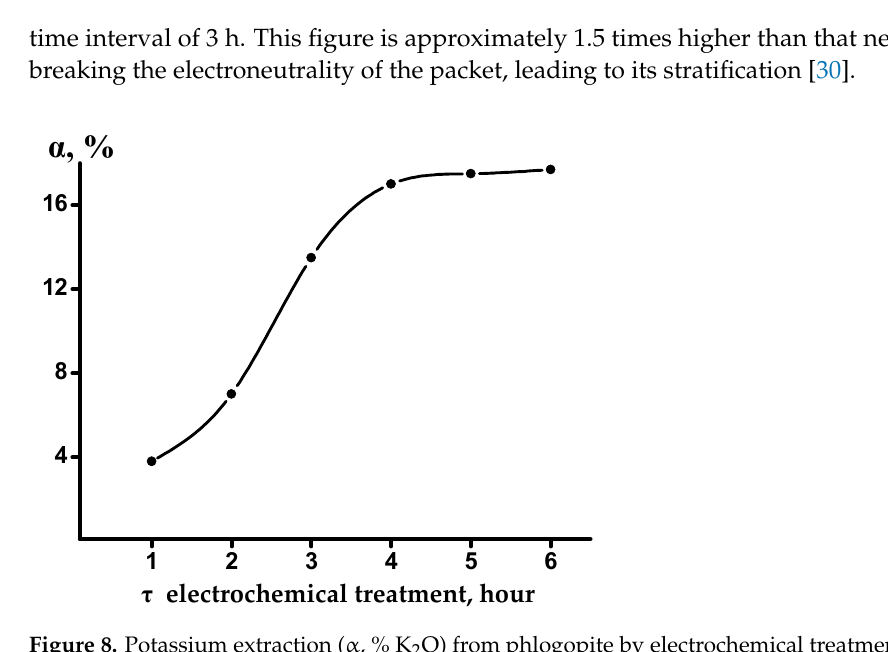
( d ) Figure 9. SEM images of mica particles. ( a ) Initial; ( b ) particles after electrochemical treatment; ( c ) particles after grinding; ( d ) after sieving. Translated with www.DeepL.com/Translator (free ver- sion). The mechanism of the process occurring in the chambers of the cell can be summa- rized as follows: At the cathode: 4H 2 O + 4e → 2H 2 + 4OH At the anode: 2H 2 O + 4e → O 2 + 4H +